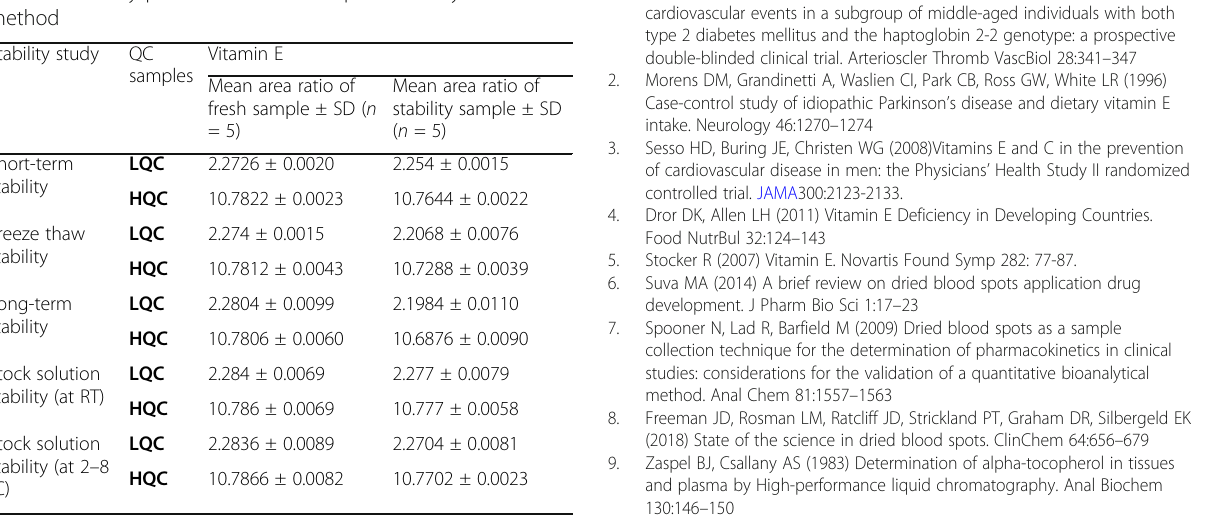
Stock solution stability (at RT)